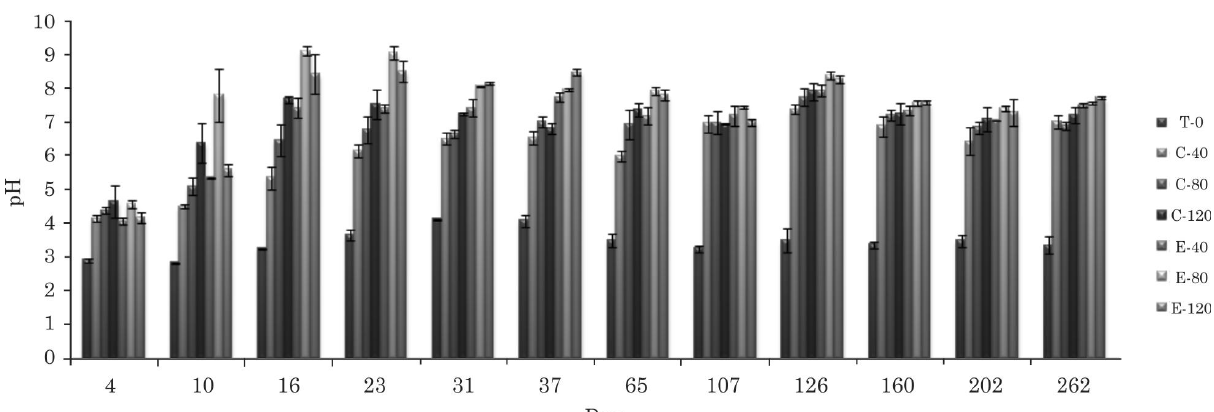
Figure 4. Average values with the respective standard errors of pH of leachates from leaching columns treated with increasing doses of limestone and steel slag doses for 262